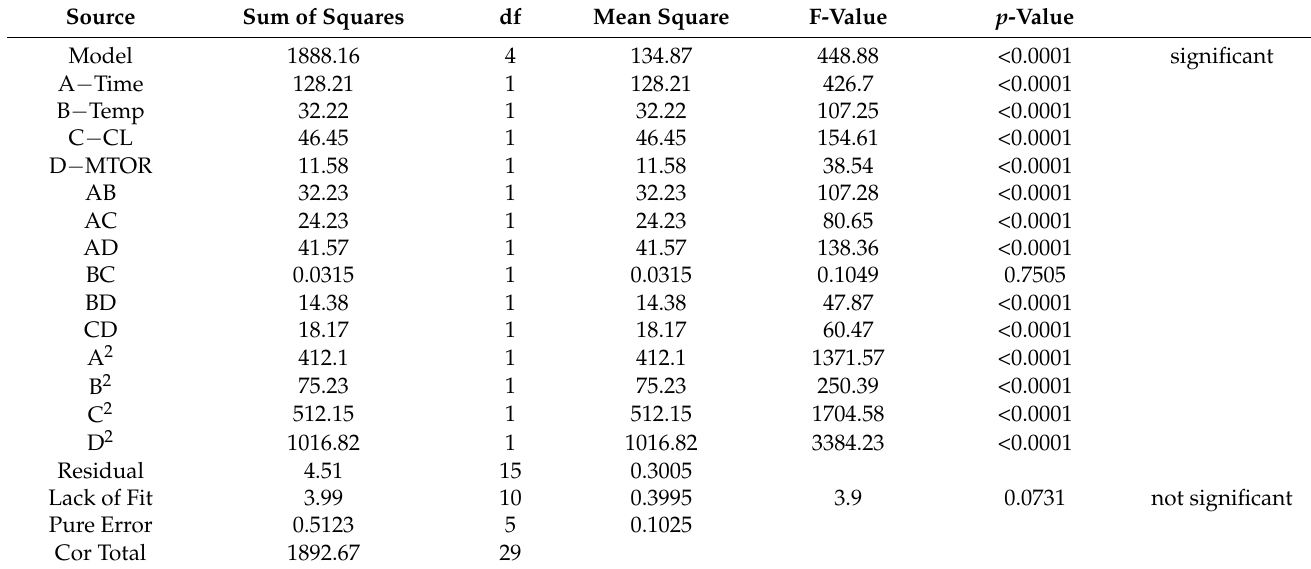
Table 3. Design matrix, actual and predicted biodiesel yields for the transesterification.